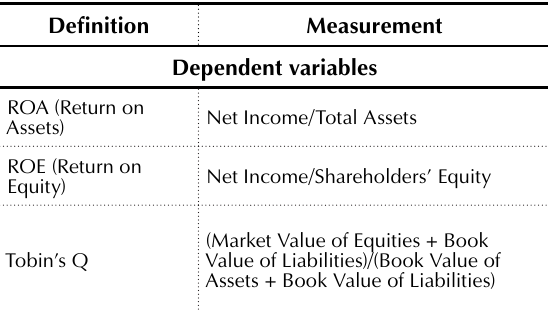
Table 2. Variable definitions and measures